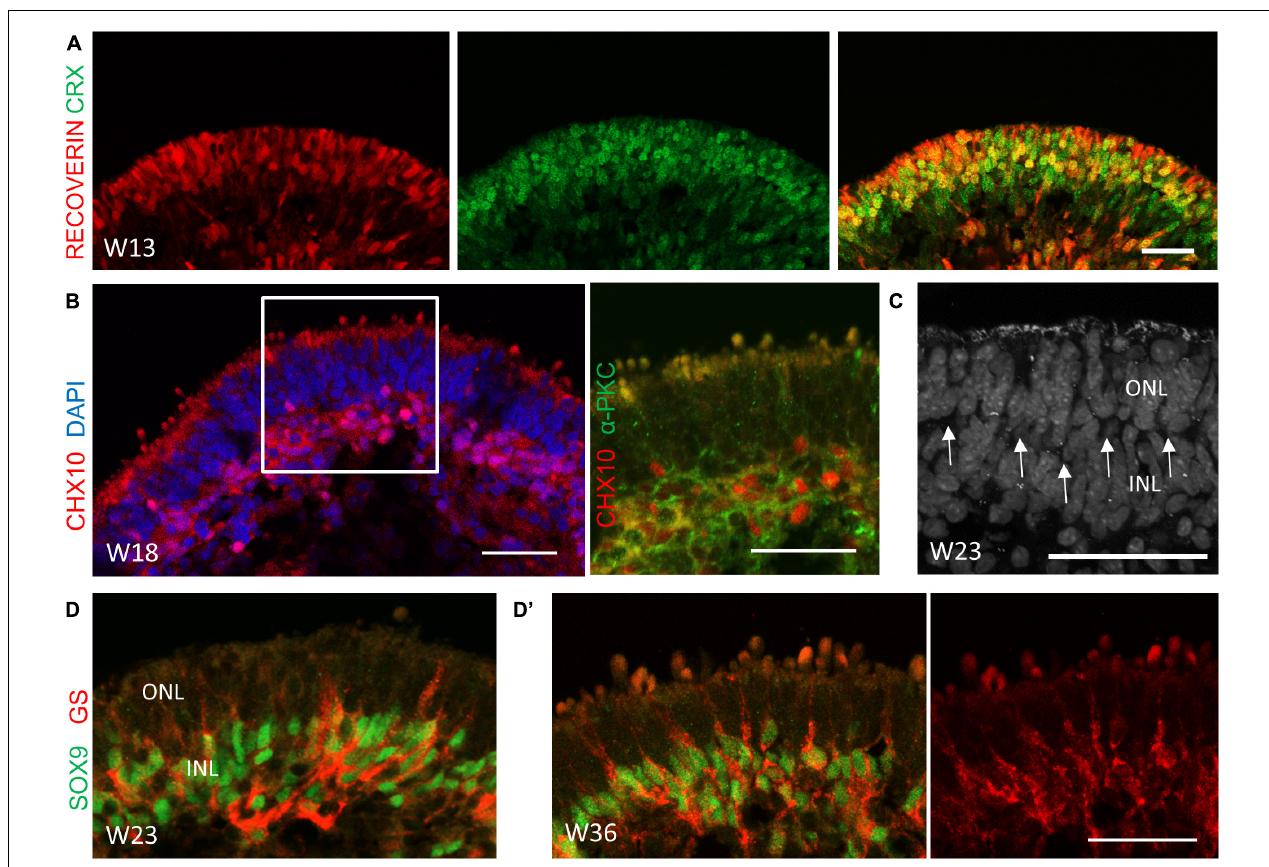
FIGURE 4 | The cellular composition of retinal organoids during the late-stage differentiation. (A) Robust derived cone and rod photoreceptor cells at Week 13 as indicated by CRX (green) and RECOVERIN (red), respectively. Scale bar = 100 µ m. (B) The co-localization of CHX10 (red) and α -PKC (green) in the presumptive inner nuclear layer (INL), suggesting the generation of bipolar cells at Week 18. (C) The nuclei-free layer between the outer nuclear layer (ONL) and the INL was illustrated by DAPI immunostaining, indicating the outer plexiform layer (OPL, arrowhead). (D) Müller glial cells were detected at Week 23 and were rapidly generated at Week 36 (D’) , as shown by immunostaining of the Müller glial cell markers SOX9 (green) and GS (red). Scale bar = 50 µ